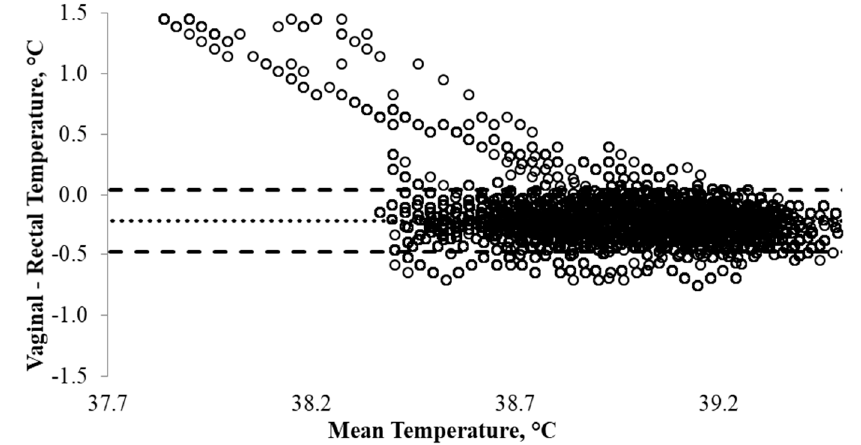
Figure 4. Bland Altman plot assessing the level of agreement between rectal temperature (T REC , °C) and vaginal temperature (T VAG , °C) recorded at the same time point and the mean difference (dotted line) and confidence intervals (95% = mean ± 1.96 × SD; dashed line). The x-axis represents the mean temperature measurement as determined by averaging rectal temperature (T REC , °C) and vaginal temperature (T VAG , °C), whilst the y-axis shows the difference in recorded temperatures for the two methods, in this instance vaginal temperature minus rectal temperature.